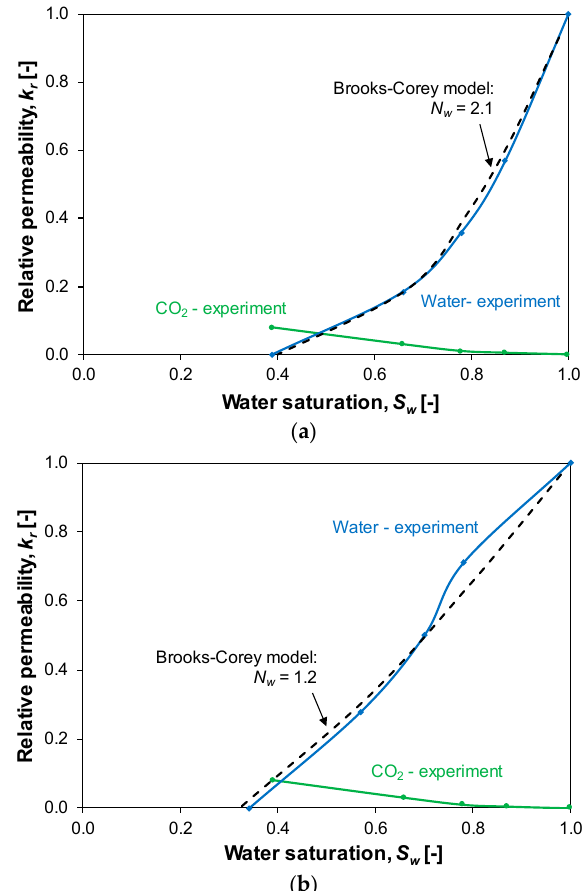
Figure 4. Relative permeability curves and fitting with the Brooks–Corey model for Apulian limestone: ( a ) pristine specimen and ( b ) CO 2 treated specimen.